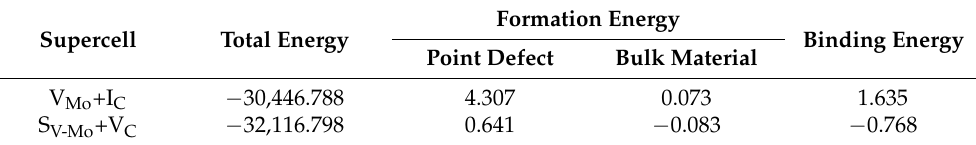
Table 4. Calculated formation energy and binding energy of Mo 2 C supercell with defect complexes